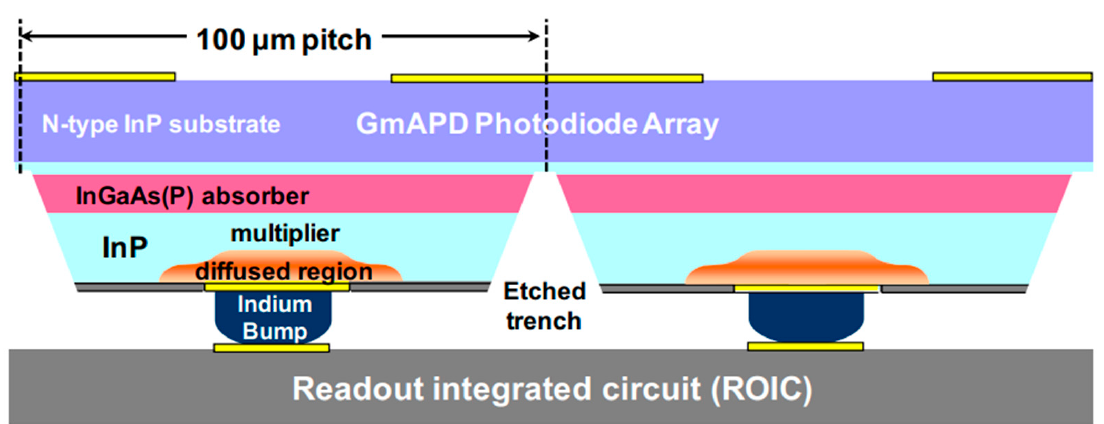
Figure 51. Schematic diagram of planar-geometry InGaAs/InP APD FPAs contacted to CMOS readout ICs via in-bump flip-chip bonding. Reproduced with permission from [107], IEEE, 2010.